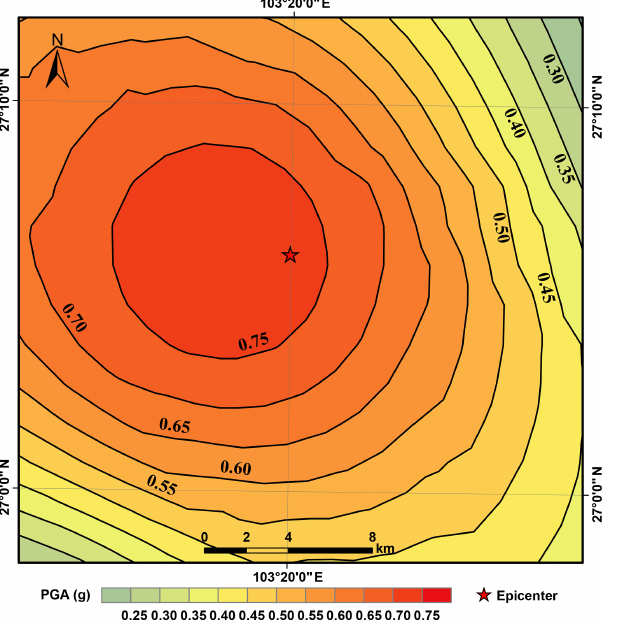
Figure 15. Contour map of peak ground acceleration (PGA) pro- duced by the Ludian earthquake in the study area. PGA values shown are in g .